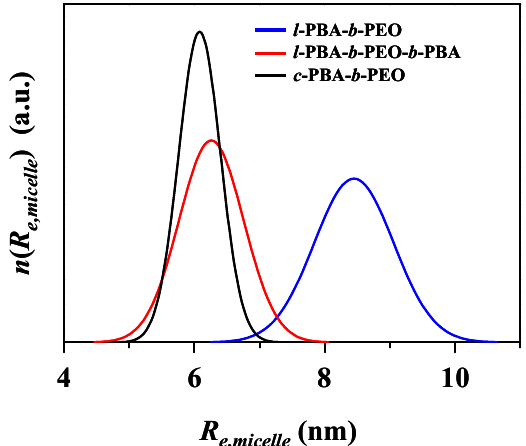
Figure 6. Size distribution curves of the micelles of topological block copolymers which are expressed based on the equatorial radius R e,micelle of micelles extracted by the scattering data analyses using a three-phase ellipsoid scheme.